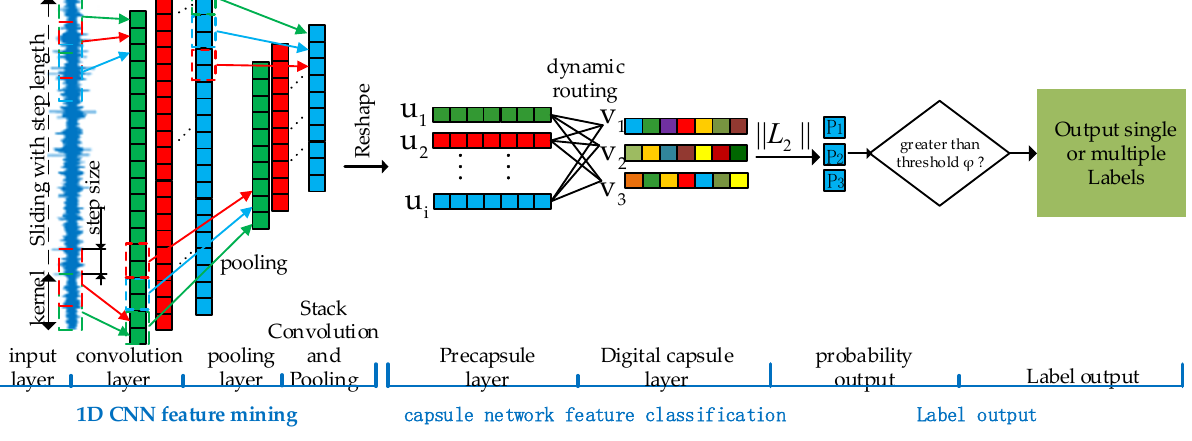
Figure 5. ECCN network structure diagram.